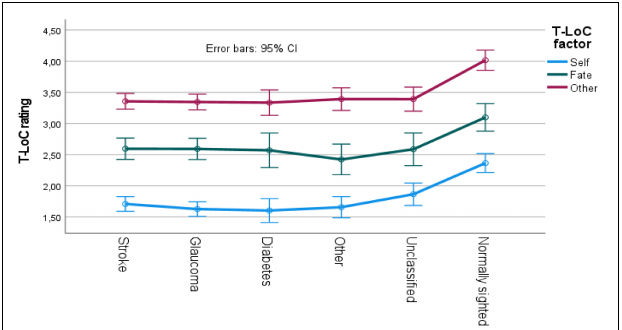
FIGURE 1 | T-LoC scale ratings for VFL and normally sighted participants. CI, confidence